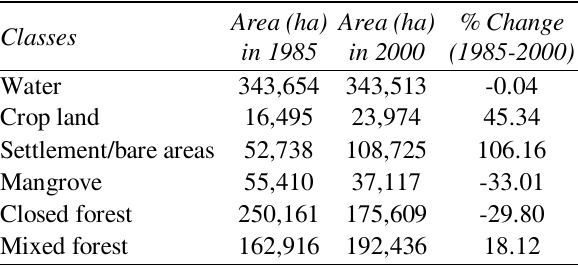
Table 2: Results of the classified 1985 and 2000